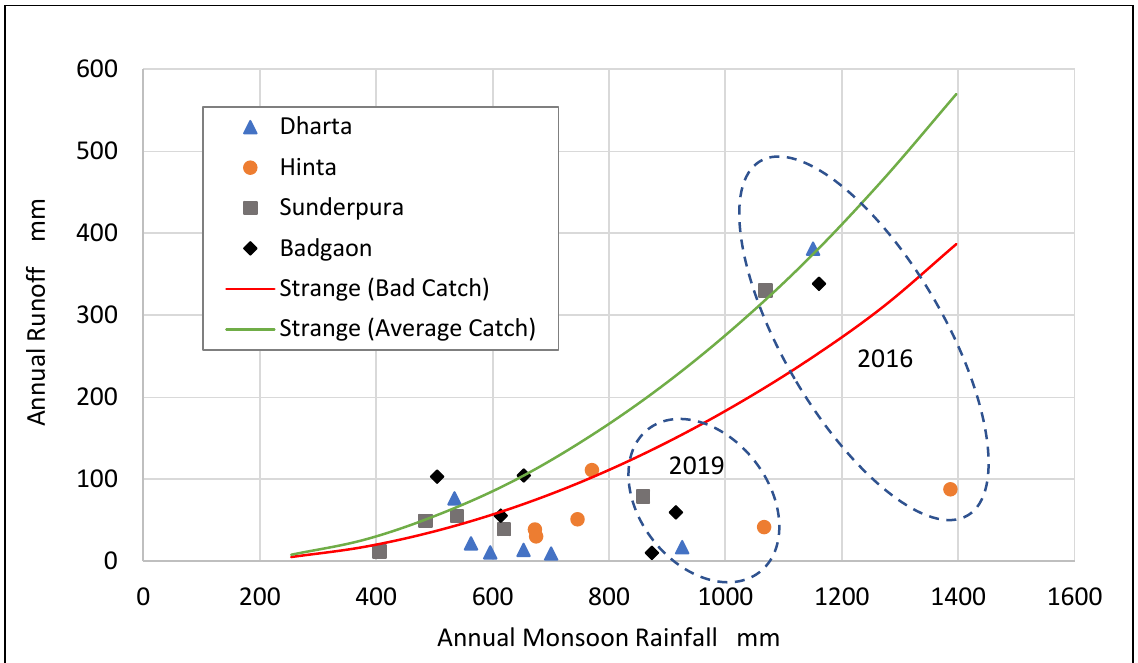
Figure 2. Annual monsoon rainfall/runoff relationships for the four study catchments.